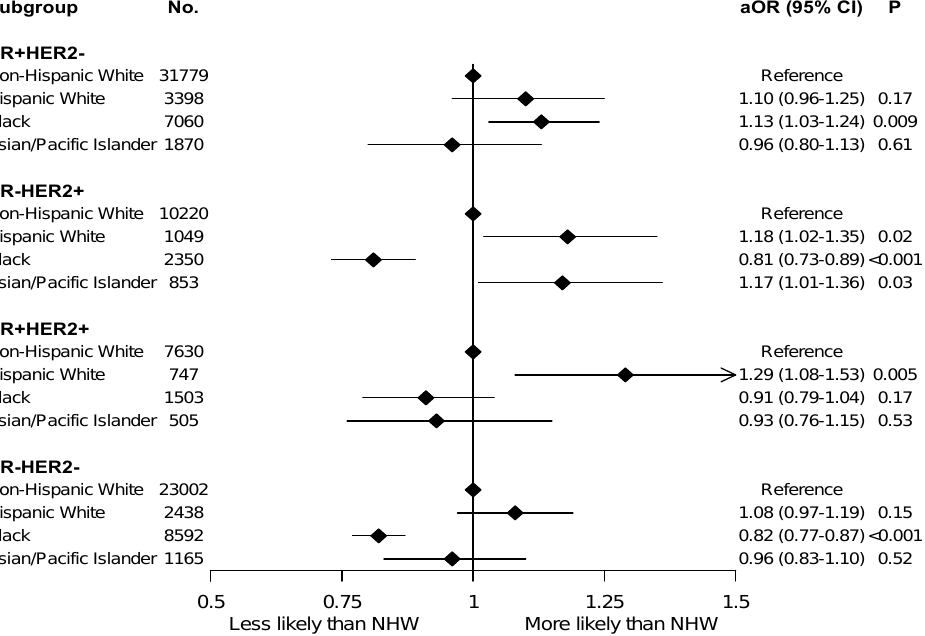
Figure 2. Logistic regression multivariable analysis for pathologic complete response stratified by tumor receptor subtypes and racial groups. No.: number; aOR: adjusted odds ratio; 95% CI: 95% confidence interval; HR: hormone receptor; HER2: human epidermal growth factor receptor 2; NHW: non-Hispanic